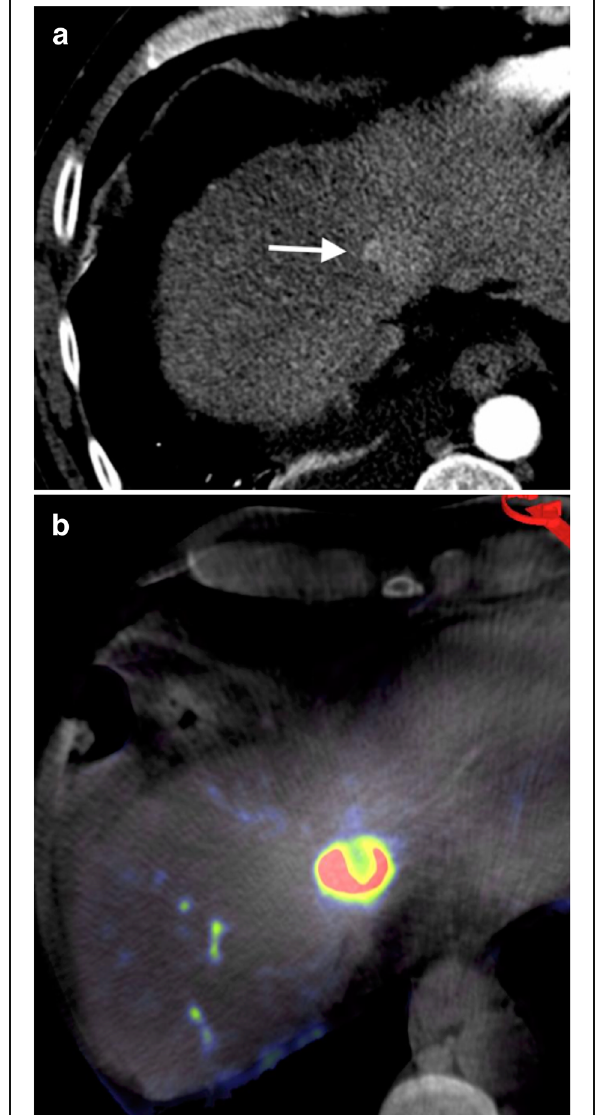
Fig. 1 a Pre-TACE arterial phase MDCT showing HCC in segment IVa/VIII (arrow). b Pre-TACE C-arm CBCT PBVI showing the same lesion